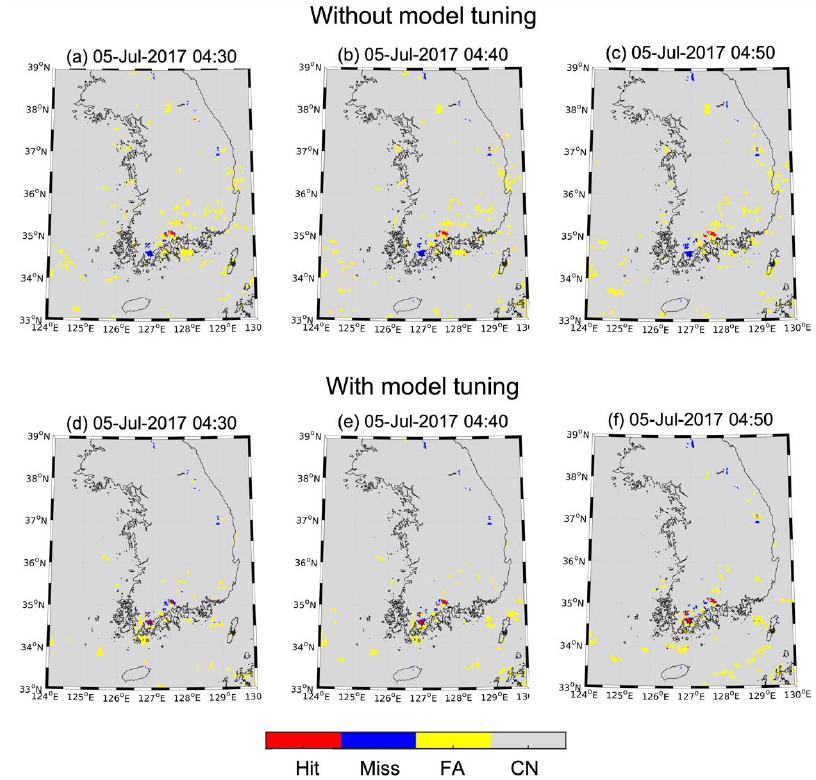
Figure 7. The spatial validation map of CI-B2 30–50 min prior to the target CI events on 05 July 2017 05:20 (corresponding to Figure 5). Results without ( a – c ) and with ( d – f ) model tuning were depicted with the same time series. FA and CN stand for a false alarm and correct negative, respectively. Note that the accuracy of the radar data could be degraded over the sea far from the inland area.